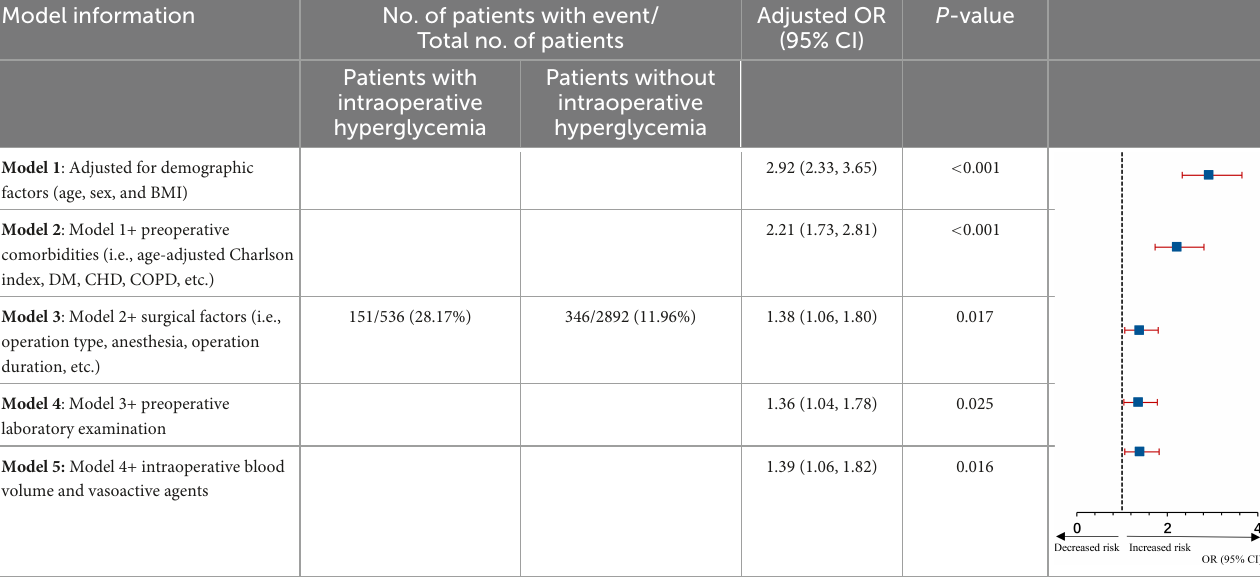
TABLE 2 Risk of postoperative infection with intraoperative hyperglycemia compared with unexposed individuals. Model